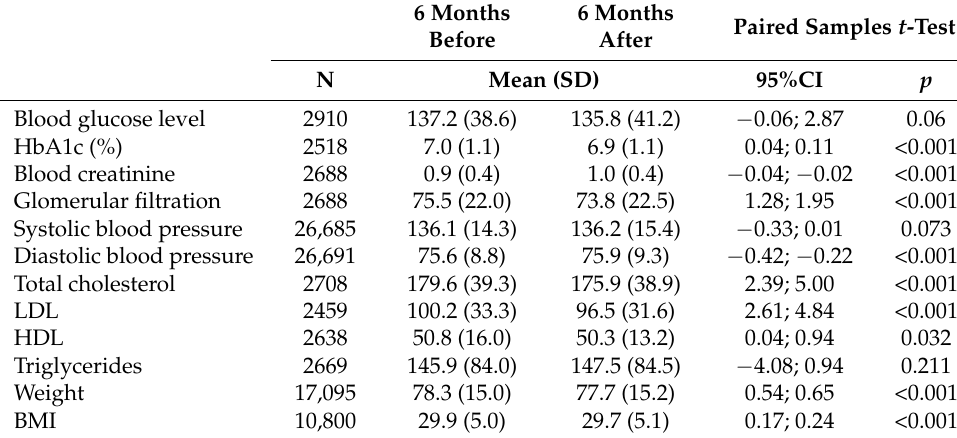
Table 2. Clinical parameters 6 months before and 6 months after